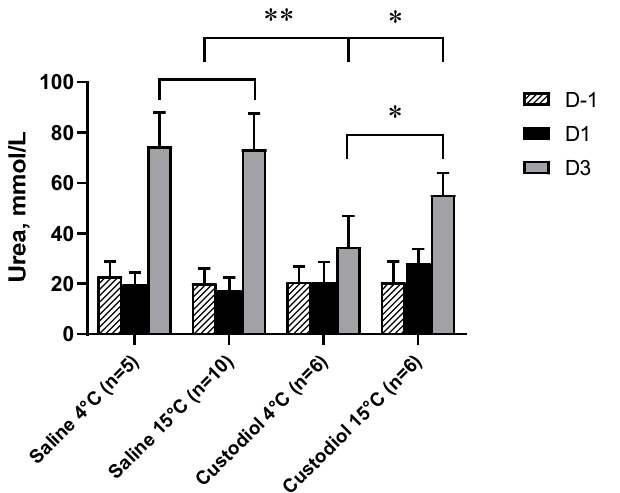
Figure 5. Plasma urea retention on days − 1, 1 and 3 (D − 1, D1, D3) in rats after flushing the kidneys with saline at 4 (n = 5) and 15 °C (n = 8) or Custodiol at 4 (n = 6) and 15 °C (n = 6) before a 30 min ischemia. Two-way repeated measure ANOVA with Tukey’s post hoc test. *: p < 0.05 between Custodiol at 4 and 15 °C and also between Custodiol at 15 °C and saline at both temperatures; **: p < 0.01 between saline at 4 and 15 °C and Custodiol at 4 °C.